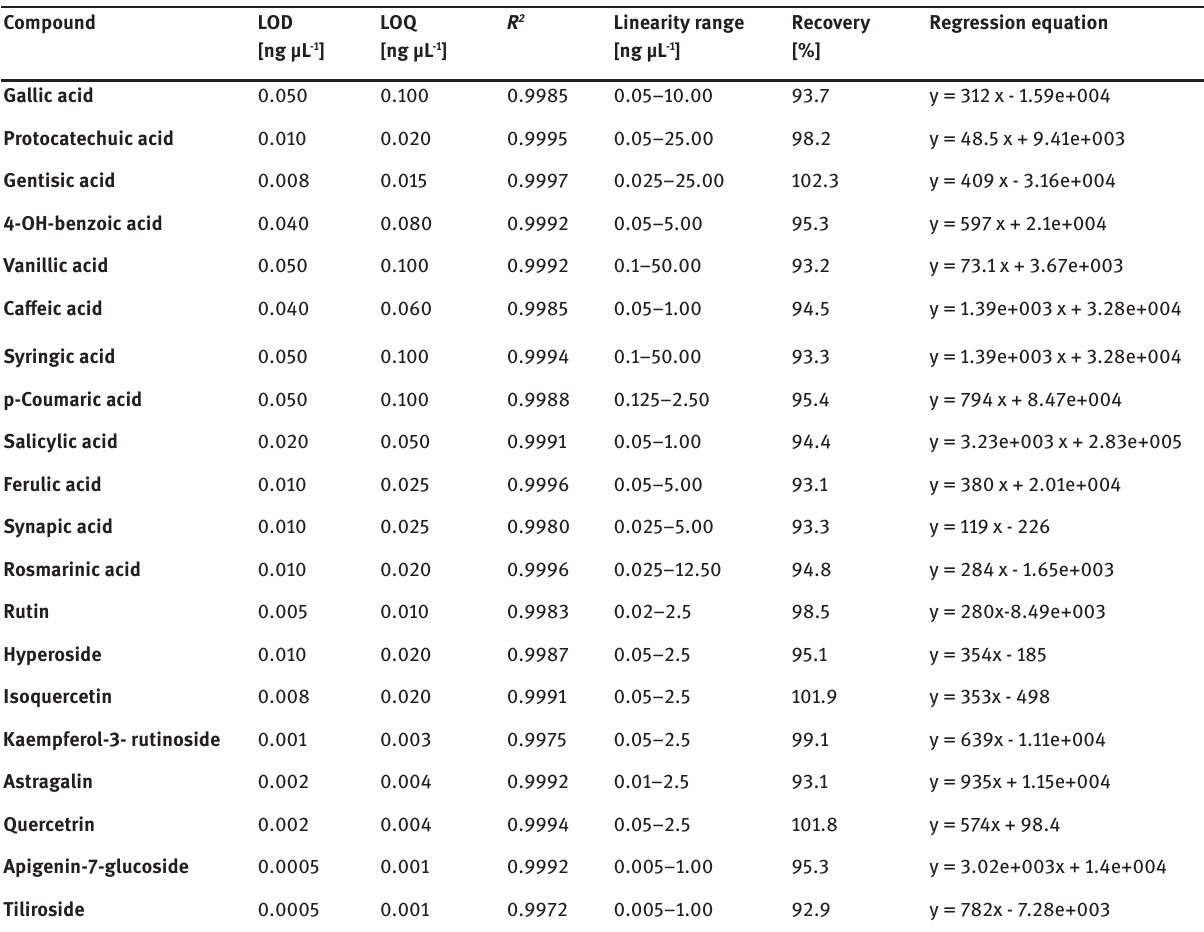
Table 3: LC-MS/MS polyphenol analytical